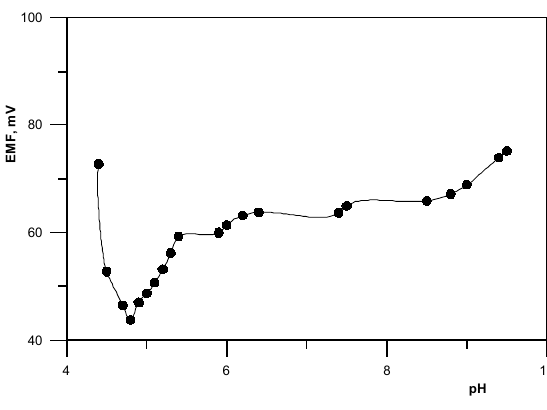
Figure 5. EMF – pH dependence of the naproxen electrode,